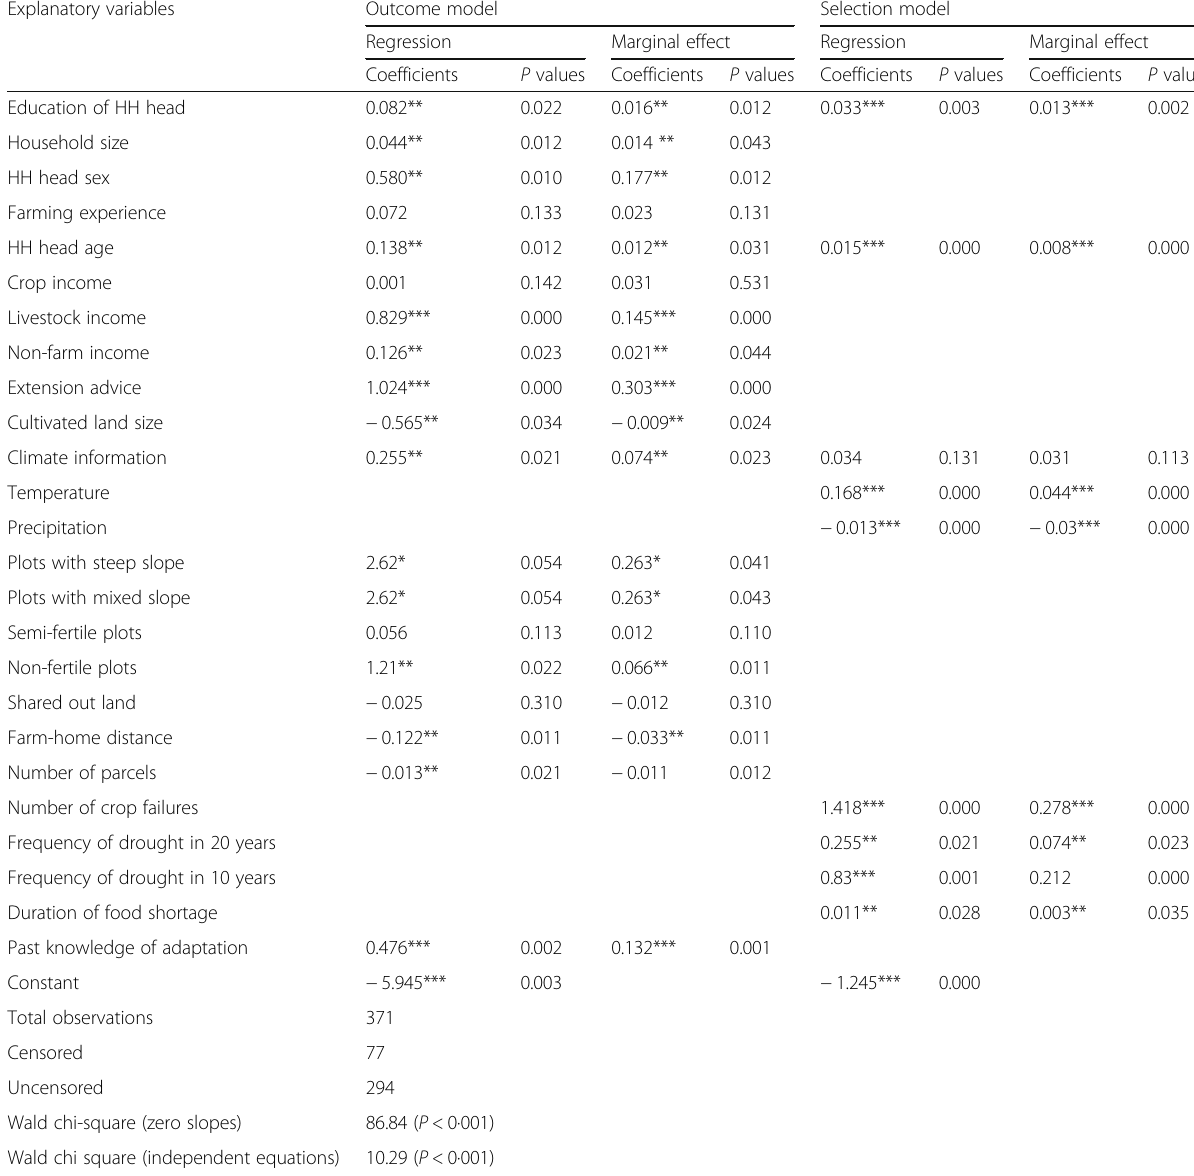
Table 8 Results of the Heckman probit selection model for the wet